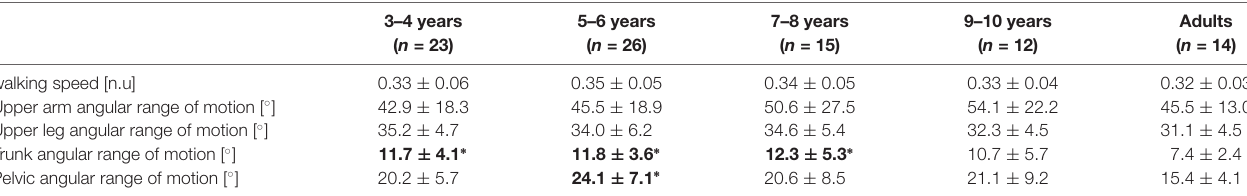
TABLE 3 | Results of walking speed and the range of motion in each segment over one